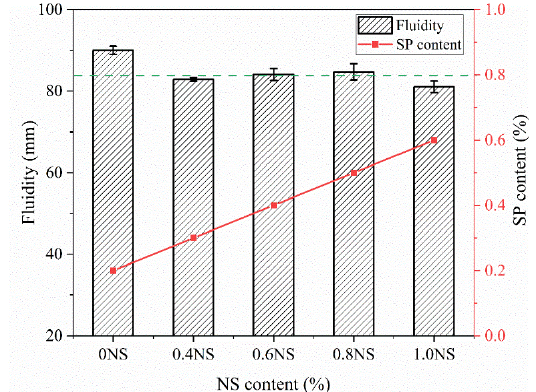
Figure 3. Influence of NS on the fluidity of the cement pastes.